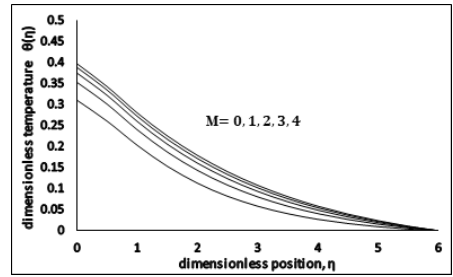
Figure 4. Dimensionless Temperature vs M .